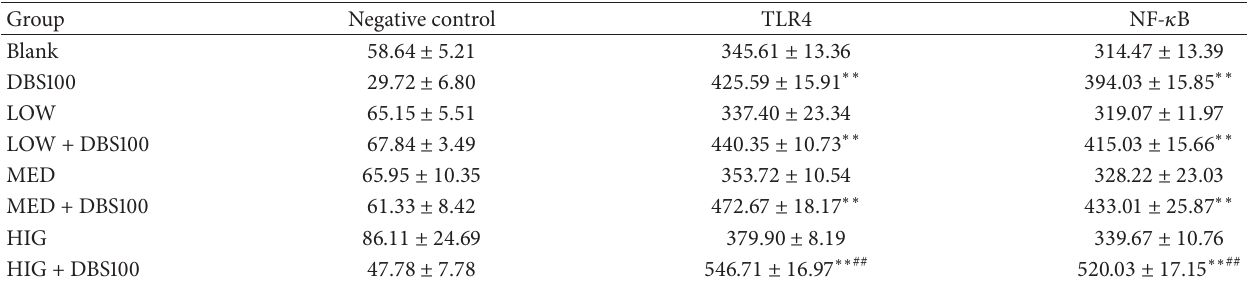
Figure 8: SEM of morphology changes. (a) Blank group; (b) DBS100 treated alone; (c) LOW treated alone; (d) LOW + DBS100 cooperative accessing; (e) MED treated alone; (f) MED + DBS100 cooperative accessing; (g) HIG treated alone; (h) HIG + DBS100 cooperative accessing, × 200-fold. CP, crypts; IM, intact microvilli; DM, disintegrating microvilli; MS, mucus secretion at crypt opening; UE, ulcers and empty. Table 5: The effect of carrageenan on the secretion of TLR4 and NF- 𝜅 B (Au, mean ± SD).